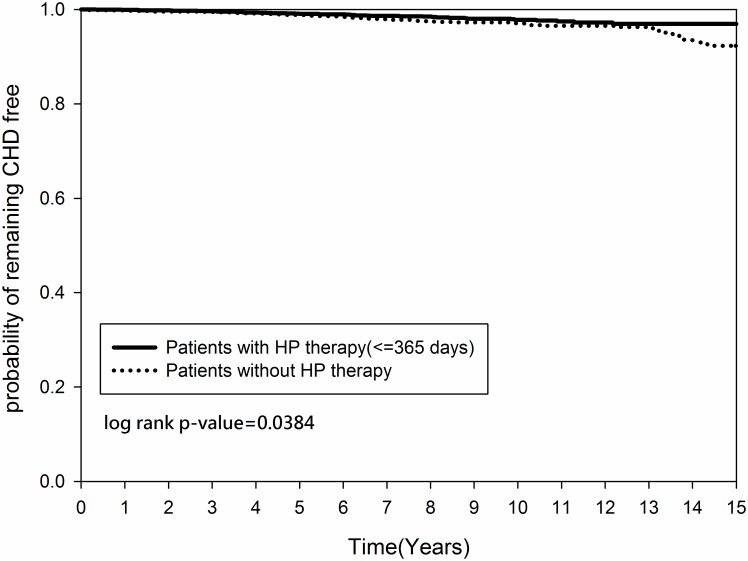
Kaplan-Meier curve for coronary heart disease rate by age between patients (age < 65 years old) with and without Helicobacter pylori therapy.